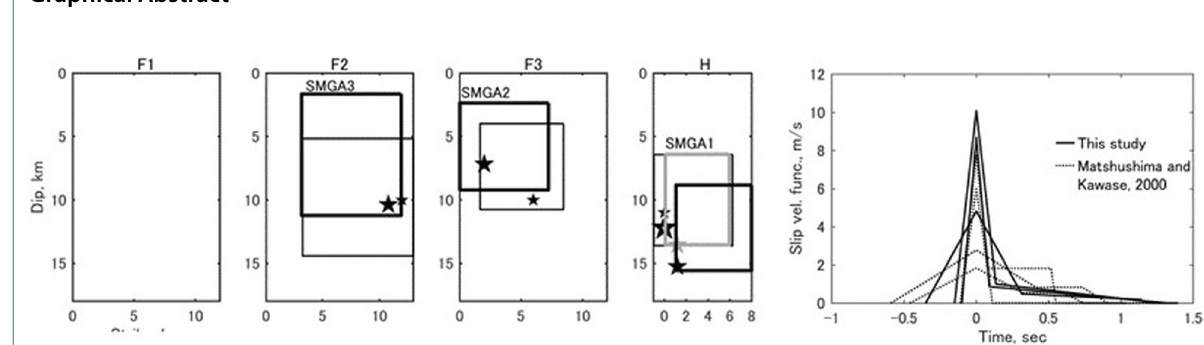
2 km/s layer of JIVSM model, in meters. Dashed square—target =